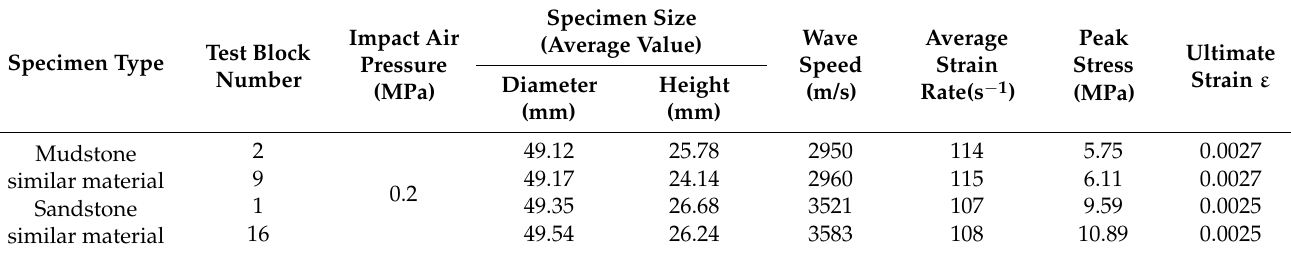
Figure 11. Splitting stress–strain curves of specimens under different impact pressures. Table 5. Results of dynamic splitting experiments for similar